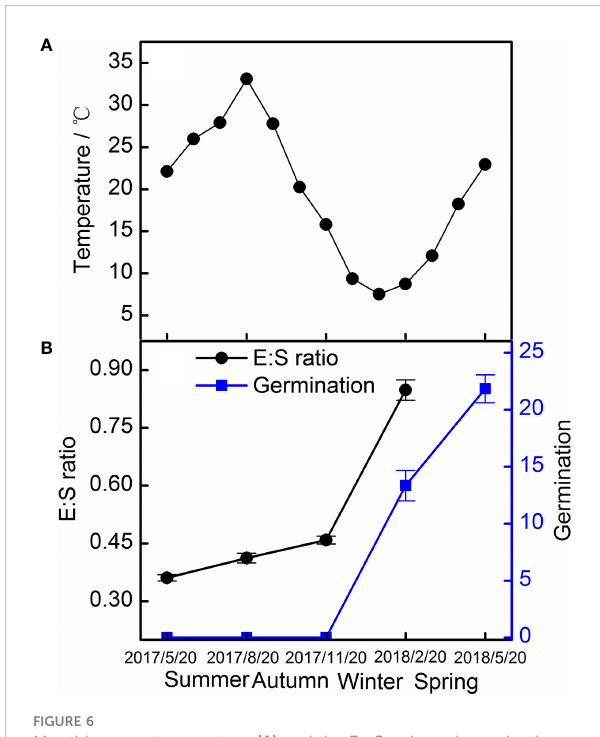
FIGURE 6 Monthly mean temperature (A) and the E : S ratio and germination of Taxus chinensis var. mairei seeds (B) in the fi eld experiment. The vertical bars represent standard errors of the mean (n = 3). E : S ratio, embryo-to-seed